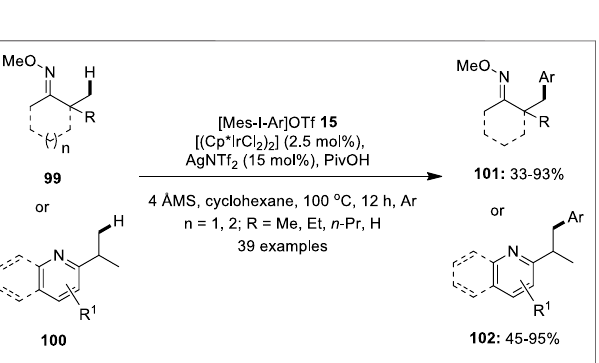
FIGURE 19 | Iridium-catalyzed sp 3 C – H bond arylation of ketoximes 99 and nitrogen-containing heterocycles 100 with diaryliodonium salts 15 .